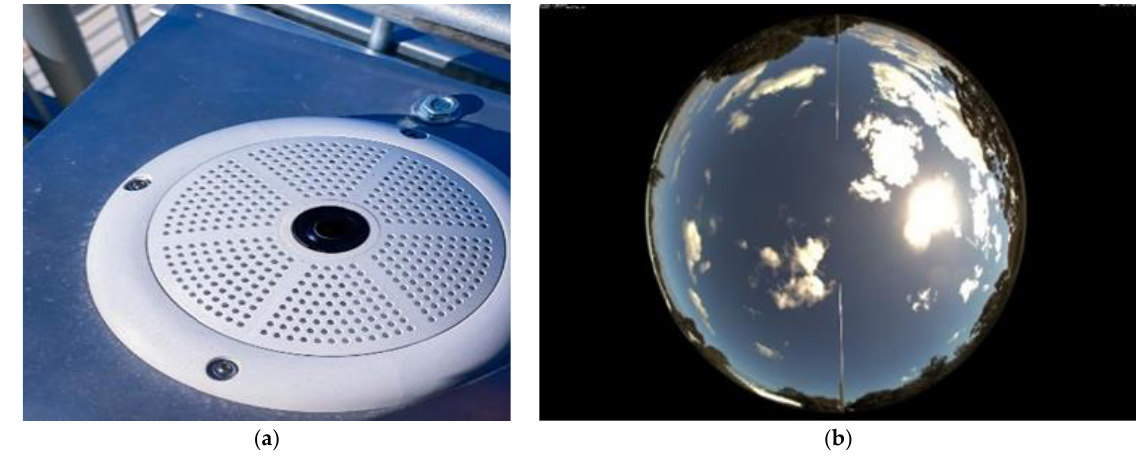
Figure 2. ( a) Mobotix 26 camera. ( b ) Sky image captured at Murdoch University in Perth. Network, Connectivity and Storage